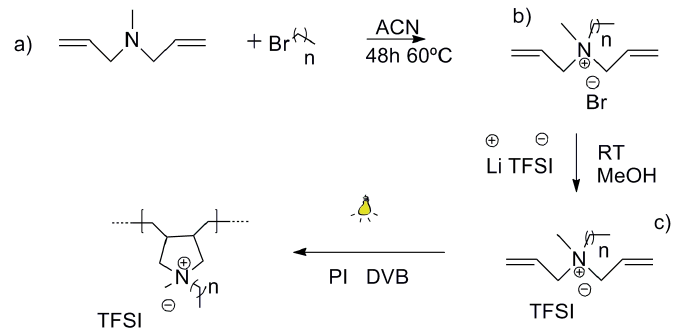
Figure 1. Overall synthetic scheme of pyrrolidinium-based poly(ionic liquids) (Pyrr-PIL) used in this work: ( a ) synthesis of the quaternary ammonium monomers with different alkyl chain lengths; ( b ) anion exchange reaction step to obtain the IL monomers with poly(methyltetradecyl pyrrolidinium) (TFSI) anion; and, ( c ) photopolymerization process.